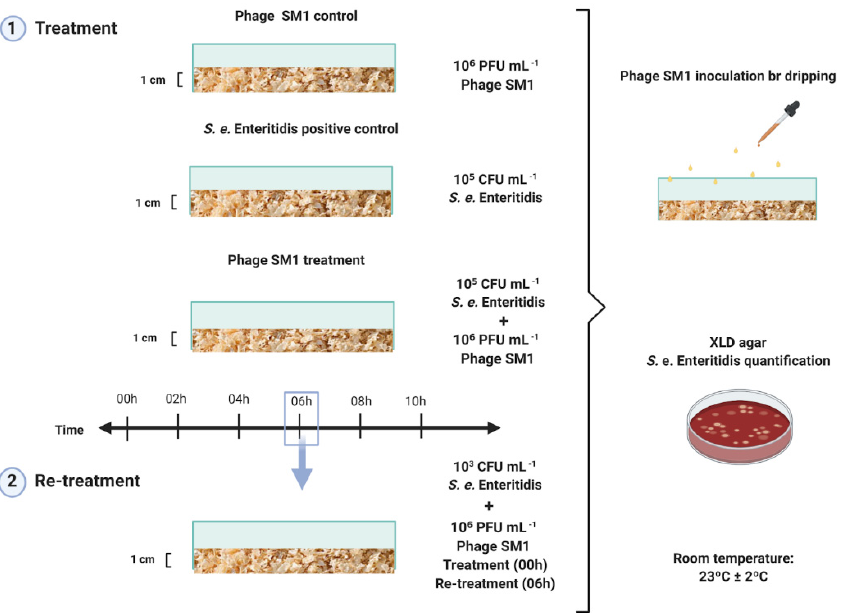
Figure 1. Scheme of the experimental system, with the treatments and controls.